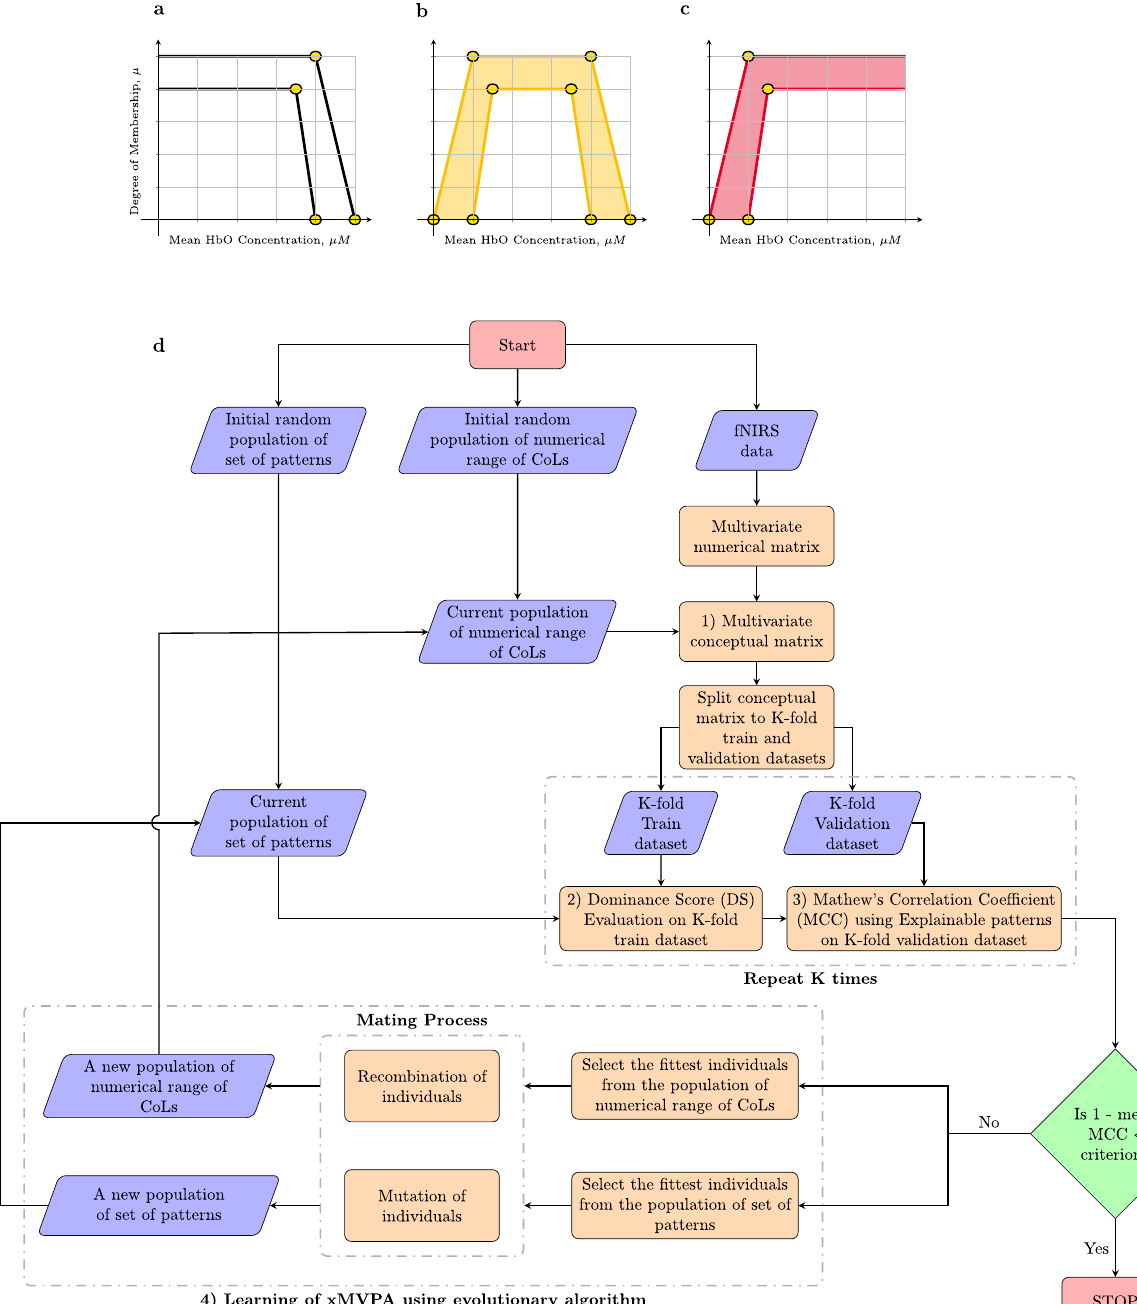
Fig. 5 A fl owchart outlining the construction of xMVPA. a − d An illustrative plot delineating the values to be learnt by the evolutionary algorithm for each of the conceptual labels (CoLs) associated with brain activity in a channel, with the corresponding degree of membership, μ , namely: inactive (white), active (amber), and very active (red). The values to be learnt for each CoLs de fi nition are encircled in yellow. For CoL inactive , the values to be learnt are 4 as shown in ( a ), for CoL active are 8 as shown in ( b ), and for CoL very active the values to be learnt are 4 as shown in ( c ). d A fl owchart depicting the steps for the construction of xMVPA. With an initial random population (of size 200) of the numerical range of CoLs, and an initial random population (of size 200) of a set of patterns, the input fNIRS data is converted into the conceptual multivariate matrix and split into fi ve-fold train and validation datasets. The dominance score (DS) of the patterns is established using train datasets, and the validation datasets are used to determine the ef fi cacy of the set of patterns based on MCC (Mathew ’ s correlation coef fi cient). The tolerance criterion, 1 × 10 − 5 , for the evolutionary algorithm is compared with the 1 − mean MCC of the fi ve-fold validation datasets to evaluate the performance of the set of patterns for correctly predicting the stimulus for un-labelled brain activity instances in the validation datasets. If the tolerance criterion is met, the xMVPA learning is complete else new populations, of size 200, of the numerical range of CoLs and set of patterns are found, and their DS and MCC on k -fold train and validation datasets are determined respectively and the process is repeated till the set tolerance criterion is achieved. The numbers in the boxes, 1) − 4), refer to the steps outlined in the section “ Methods ” : a MVPA method via XAI (xMVPA) for the construction of the